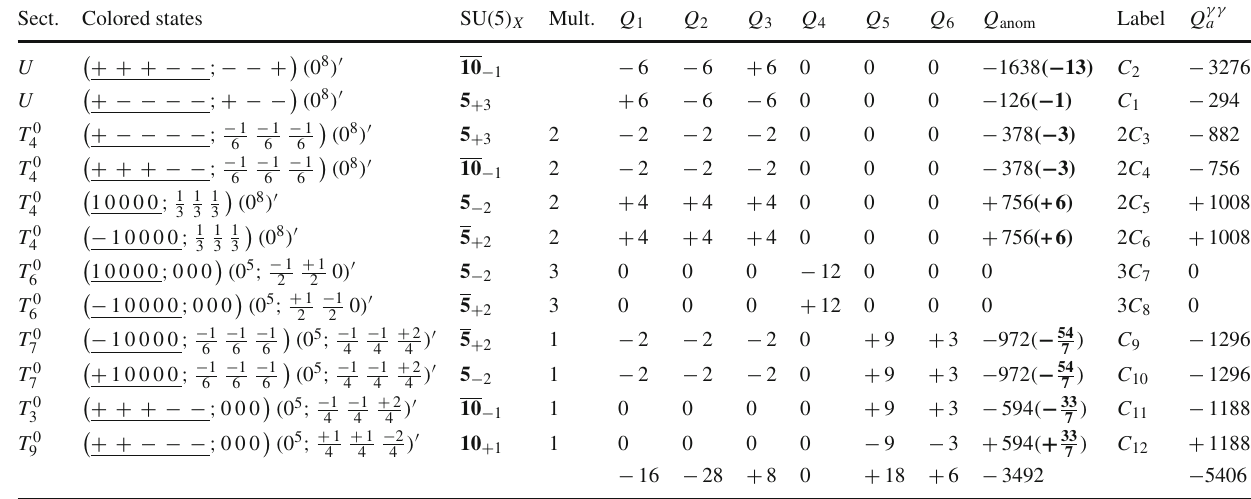
Table1 The SU ( 5 ) × U ( 1 ) X states.Here,+representshelicity + 1 chiral, counts quark and antiquark in the same way. The right-handed and 2 states in T 3 and T 5 are converted to the left-handed ones of T 9 and T 7 , . Sum of Q anom is multiplied by the index of – represents helicity − 1 2 respectively. The bold entries in the column Q anom are Q anom / 126 the fundamental representation of SU(3) c , 1 . The PQ symmetry, being 2 Sect. Colored states SU(5) X Mult. Q 1 Label Q